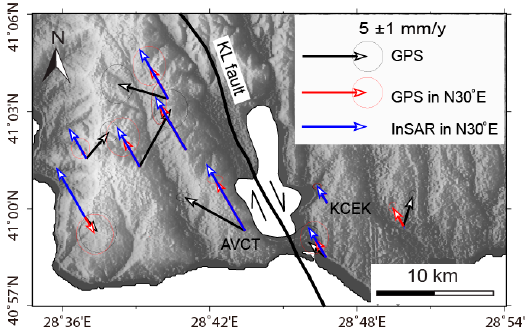
Figure A1. Comparison between the obtained InSAR velocity and the observed GPS velocity in the study area. The observed horizontal GPS velocities (black arrows) were projected onto the N30°E direction (red arrows). The horizontal InSAR velocity (blue arrows) on each GPS station was the average value of InSAR points within 1 km surrounding the GPS site. AVCT and KCEK are continuous stations, and others are survey sites.